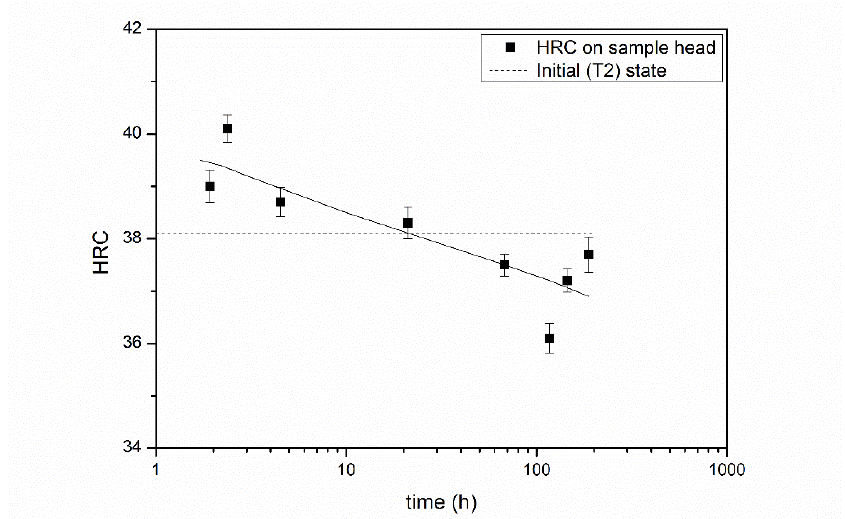
Figure 8. HRC variation and standard error with time of exposure. Hardness was measured on the heads of the crept samples to investigate the possible aging/over-aging in almost unstressed por- tions of the